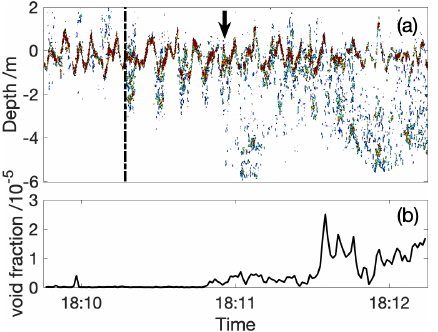
Figure 5. Panel (a) shows a contour plot of sonar backscatter dur- ing a 150s period on 2 November from 18:10–18:12. The red colour indicates the strong reflections from the instantaneous sea surface, showing the passing waves. The vertical dotted line shows the time that the whitecap was observed in the foam camera images which coincides with the appearance of a shallow bubble plume. The bold arrow is aligned with the rapid deepening of the bubble plume ap- proximately 40s later. Panel (b) shows the void fraction observed by the submerged bubble camera (at 2m) during the same period.